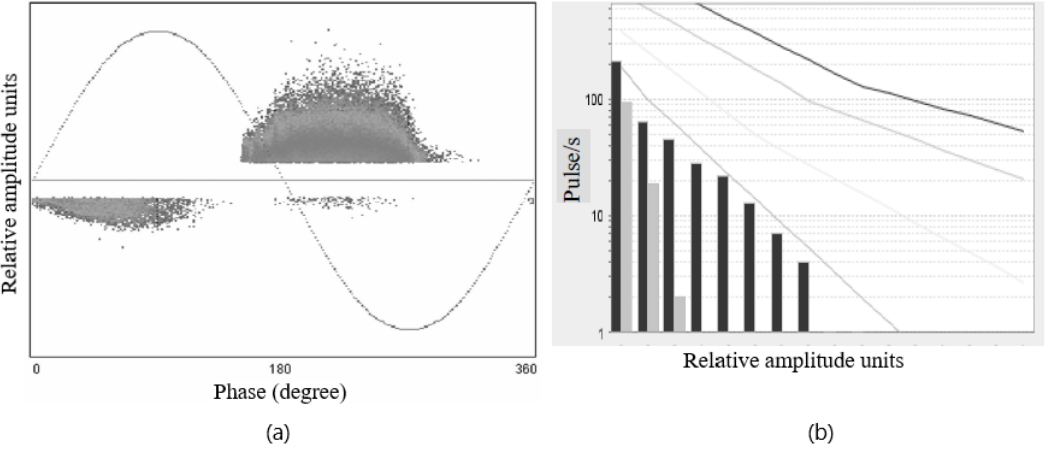
Figure 9. ( a ) PRPD pattern, ( b ) 2D equivalent